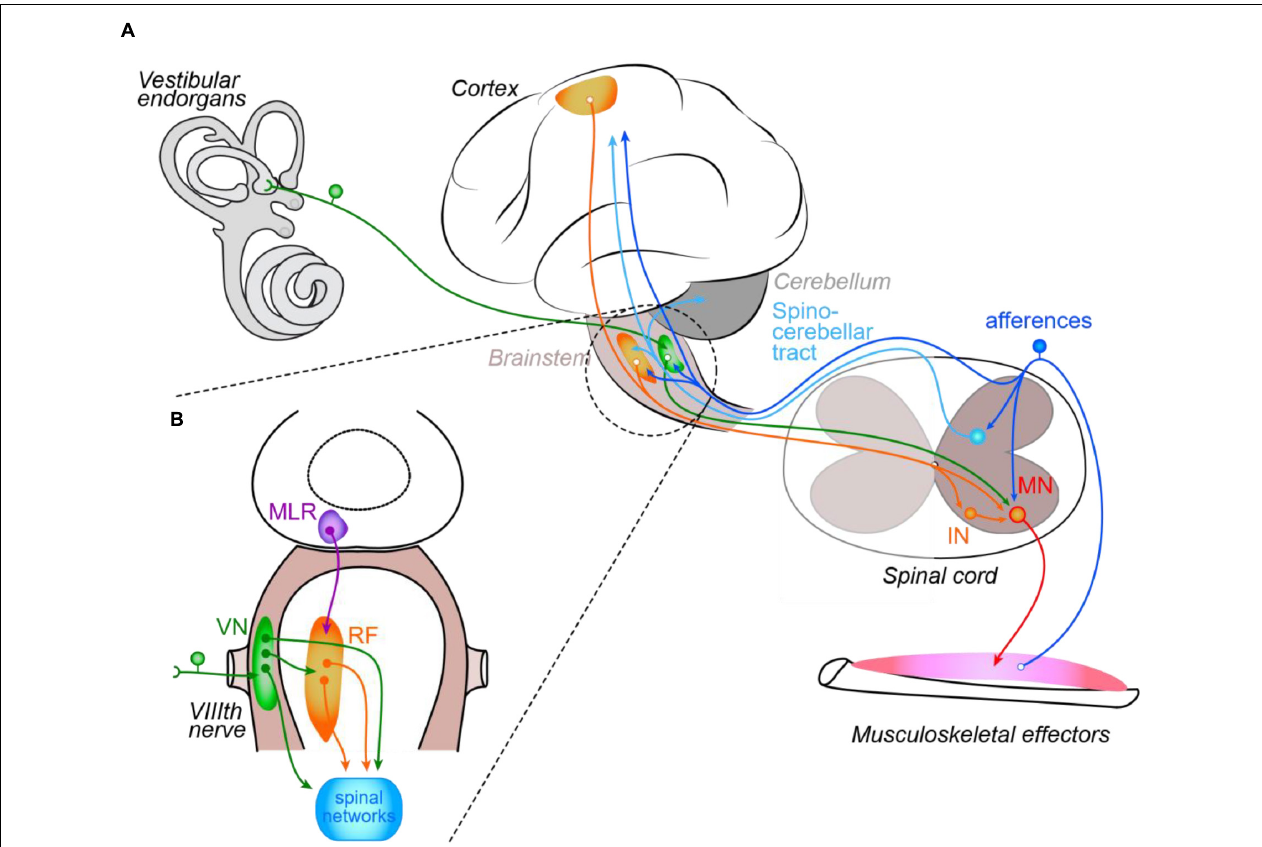
FIGURE 1 | Schematic organization of the control of posture and locomotion in vertebrates. Illustrated central and peripheral structures and connecting pathways (A) are arbitrarily limited to those discussed in the review. The inset (B) focuses on the main brainstem structures responsible for posturo-locomotor